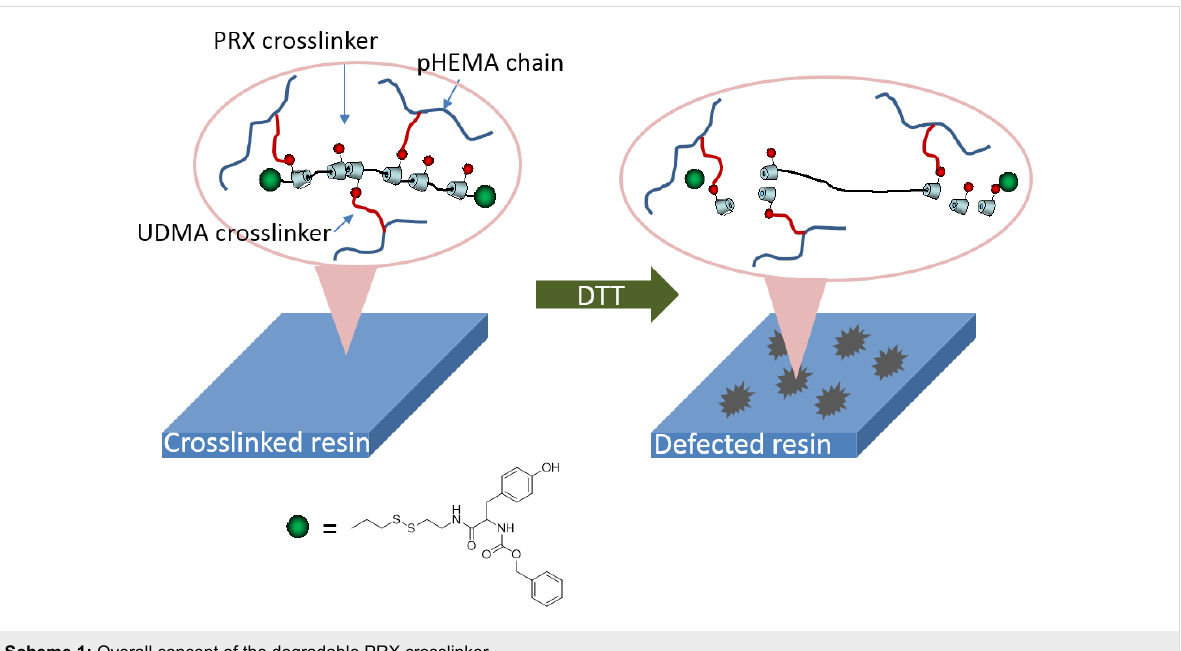
Scheme 1: Overall concept of the degradable PRX